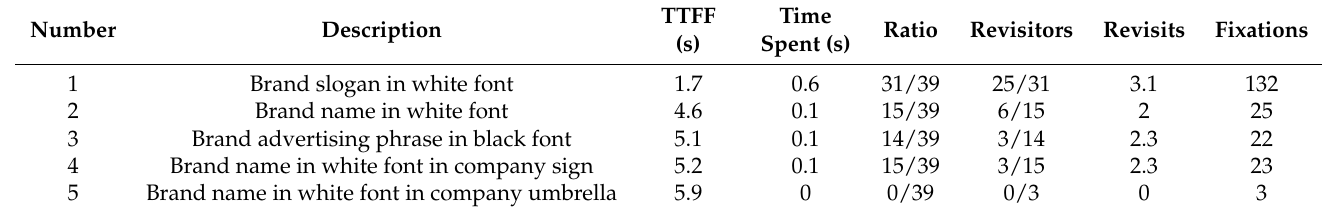
Table A3. Old website design: area of interest (AOI) metrics. Note: time to first fixation (TTFF).